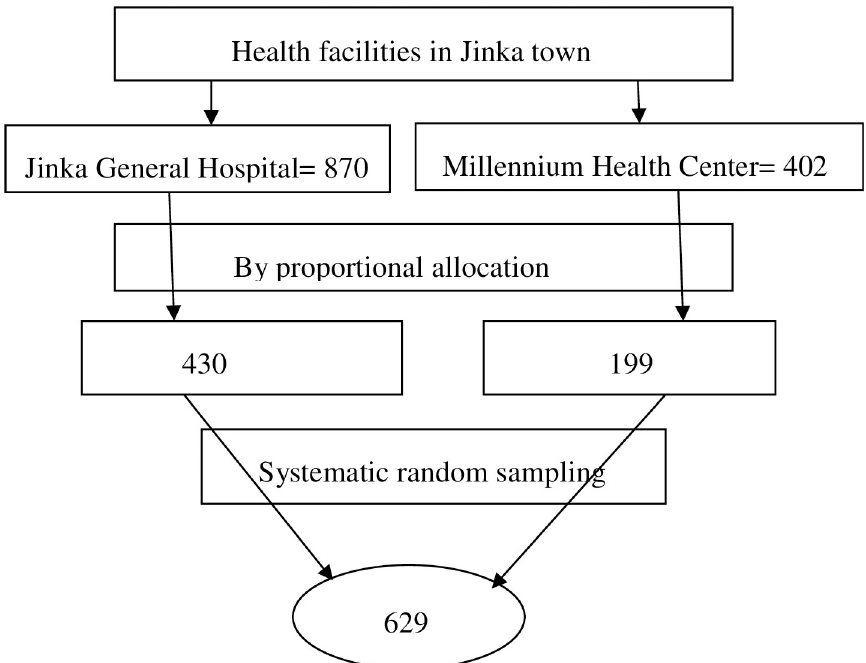
Fig 1. Schematic diagram for how the pregnant women were selected for a study of the magnitude of syphilis and associated factors among pregnant women in public health facilities of Jinka town, southern Ethiopia, 2020.